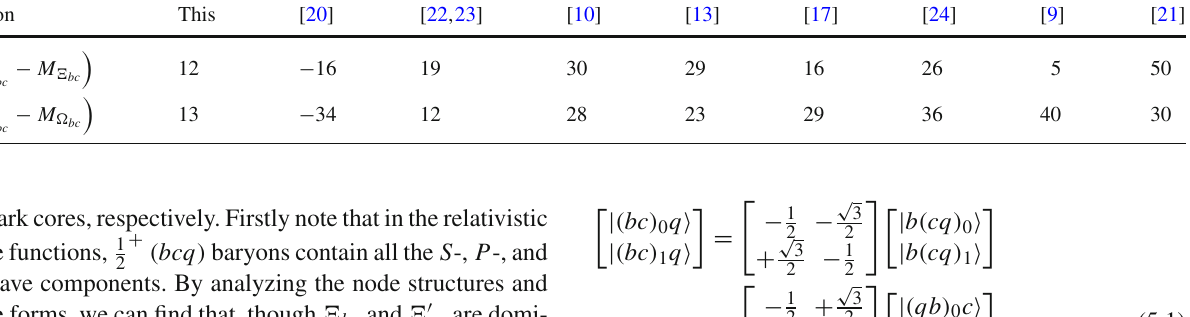
+ ( (cid:3) 1 bcq ) baryons bc and bc denote the 2